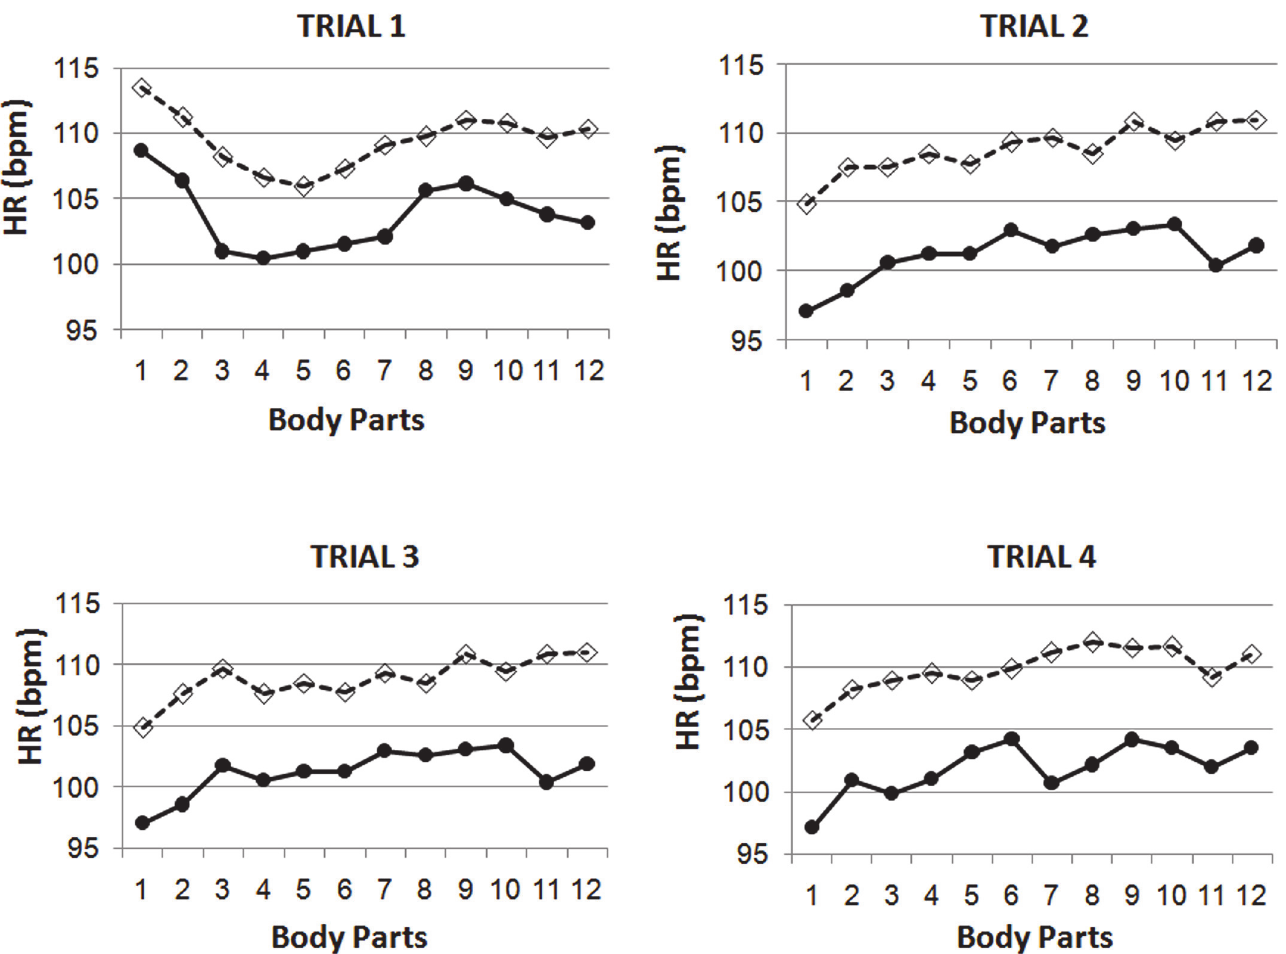
Fig 1. Heart rate (HR) responses. Peak HR values along the view of the 12 body parts (in the order: (1) open the mirror, (2) look ahead at the whole body, (3) back of the body, (4) face and head, (5) neck and shoulders, (6) arms, (7) chest, (8) abdomen, (9) buttocks, (10) thighs, (11) hips, and (12) calves) during the four exposure trials as a function of group. (discontinuous lines and open rhombs represent the low body dissatisfaction group and continuous lines and closed circles the high body dissatisfaction group).